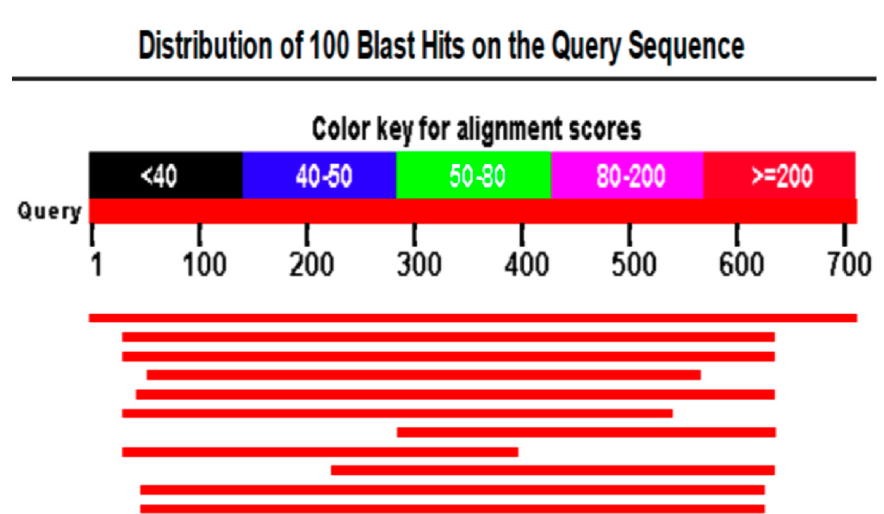
Fig. 3. BLAST analysis of the sequence